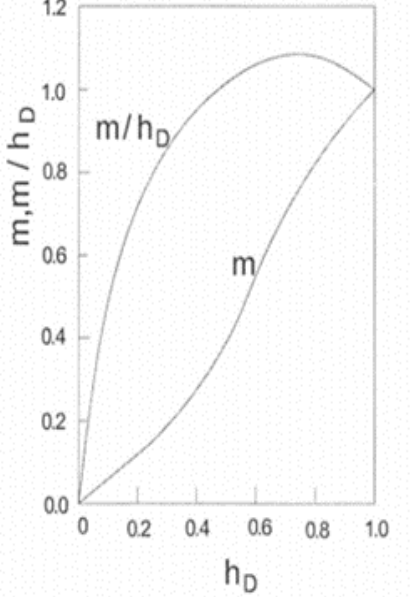
Figure 3. The relationship between ℎ 𝐷 and 𝑚 , 𝑚/ℎ 𝐷 .